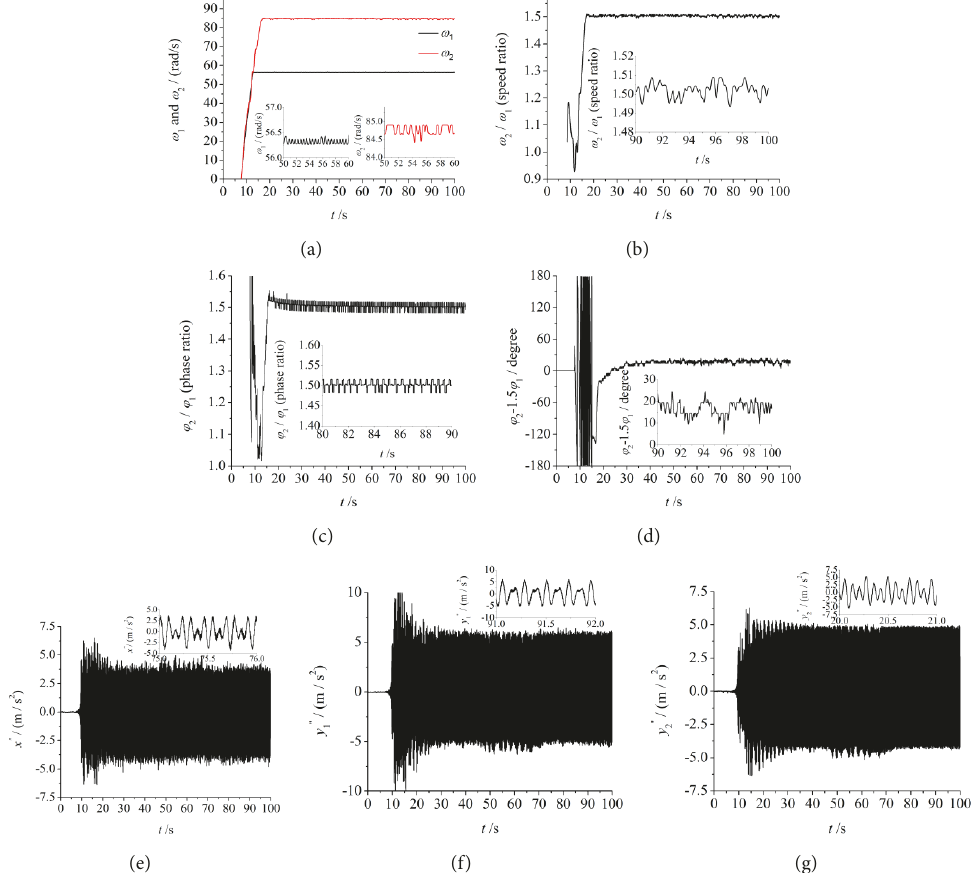
Figure 11: The experiment of the multifrequency controlled synchronization, where 𝜂 = 30 % and 𝛼 0 = 0 . (a) The speed of the two motors. (b) The speed ratio. (c) The phase ratio. (d) The phase difference. (e) The response of the 𝑥 direction. (f) The response of the 𝑦 1 direction. (g) The response of the 𝑦 2